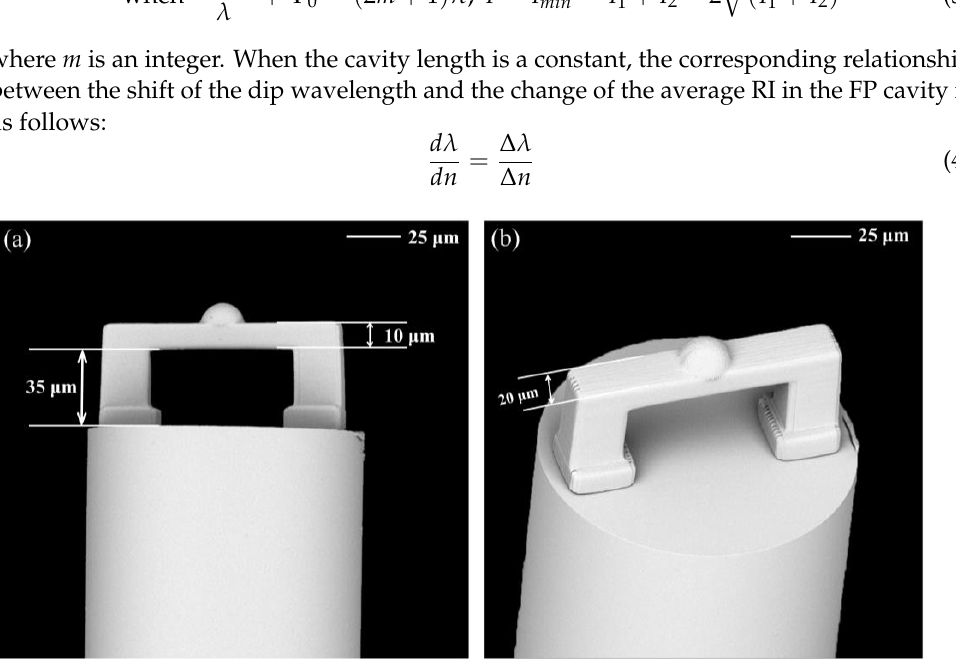
Figure 4. Typical SEM images of the microstructure on the end of the optical fiber manufactured using TPP technology. ( a ) Front view and ( b ) top view of the fixed-supported bridge. Scale bar: 25 μ m.